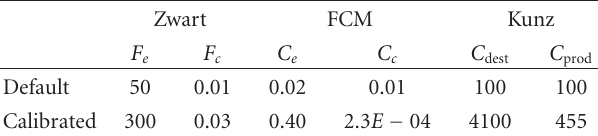
Table 1: Default and calibrated coe ffi cients for the di ff erent mass transfer models.